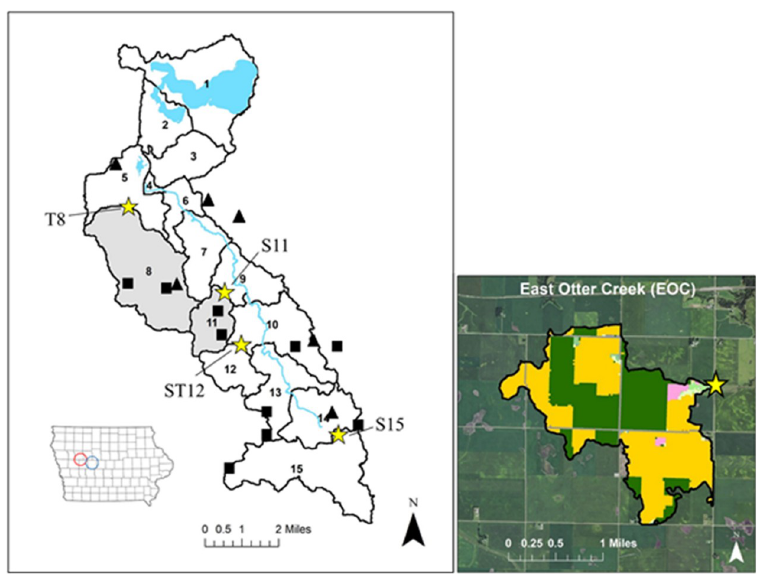
Fig 1. Monitored locations in the Black Hawk Lake watershed and the control catchment. Black Hawk Lake watershed (left; red circle) monitoring locations marked by yellow stars. The grey shaded regions indicate monitored catchments known to receive manure. Triangles indicate beef/dairy feedlots and squares indicate swine confinements. The East Otter Creek (EOC) catchment (right; blue circle) and monitoring location. Satellite imagery source: USDA NAIP